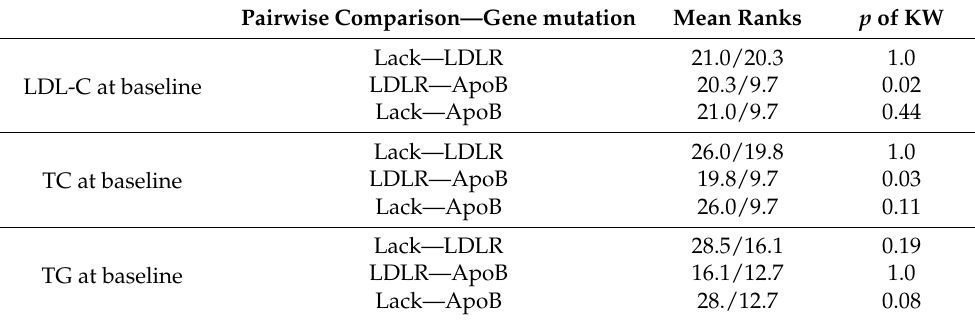
Table 3. Post hoc pairwise comparison for independent Kruskal–Wallis